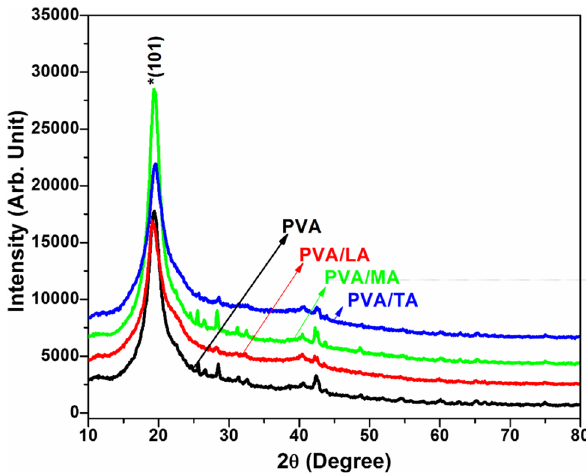
Fig. 3 X-ray diffraction patterns of PVA, PVA/LA, PVA/MA, and PVA/TA films